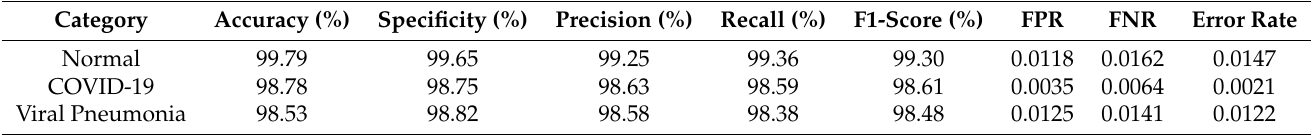
Table 10. Performance measures for optimized ResNet-50 for CT images.